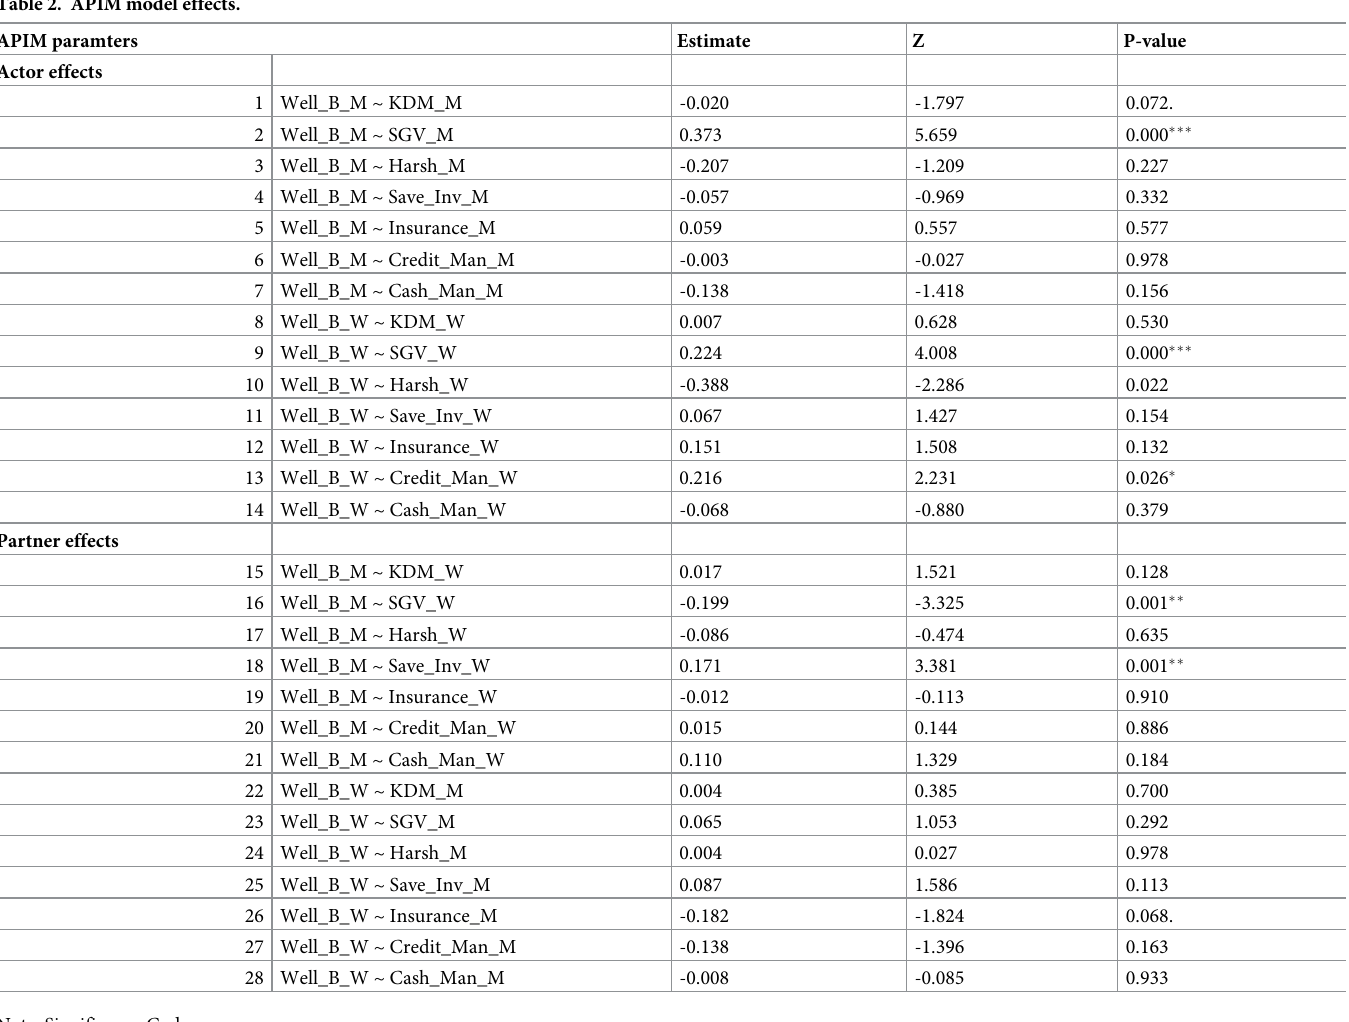
Table 2. APIM model